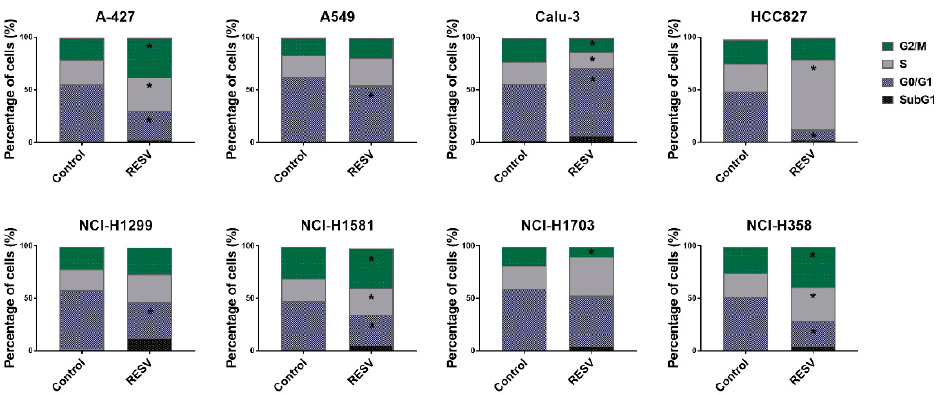
Figure 2. Flow cytometry cell cycle analysis of lung cancer cells after treatment with resveratrol (RESV) (20 µM). Data were analyzed using the Flowing Software v2.5.1. * Compared to control (untreated cells) ( p < 0.05, Student’s t -test).